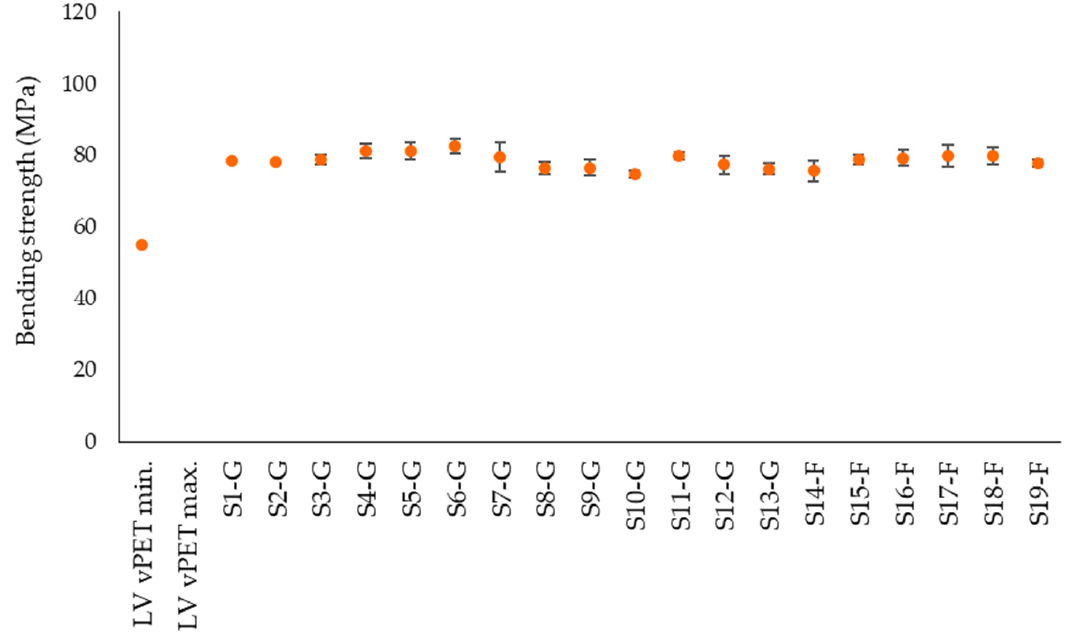
Figure 7. Experimentally determined bending strength of rPET samples in comparison with literature values for vPET.